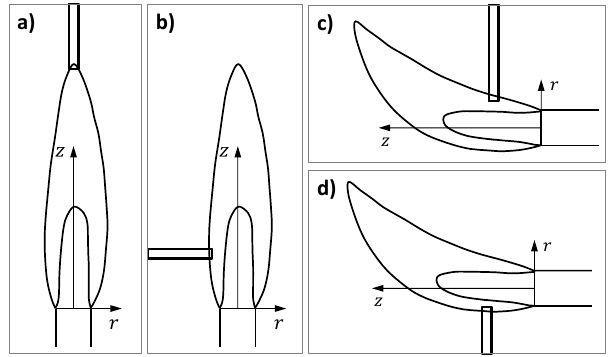
Figure 1. Fire shaping approaches depending on where the capillary is heated: ( a ) Top of a Vertical Flame (TVF), ( b ) Side of a Vertical Flame (SVF), ( c ) Top of a Lateral Flame (TLF) [26], and ( d ) Bottom of a Lateral Flame (BLF). The latter is the approach used in this